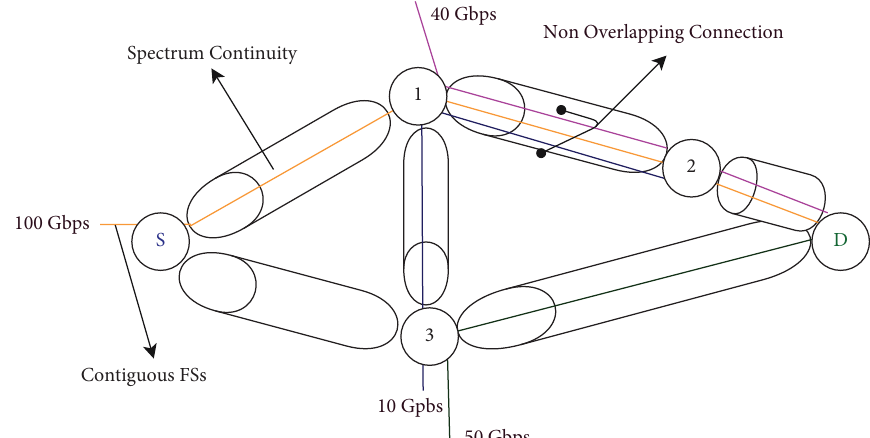
Figure 1: Tree constraints in the RSA problem.